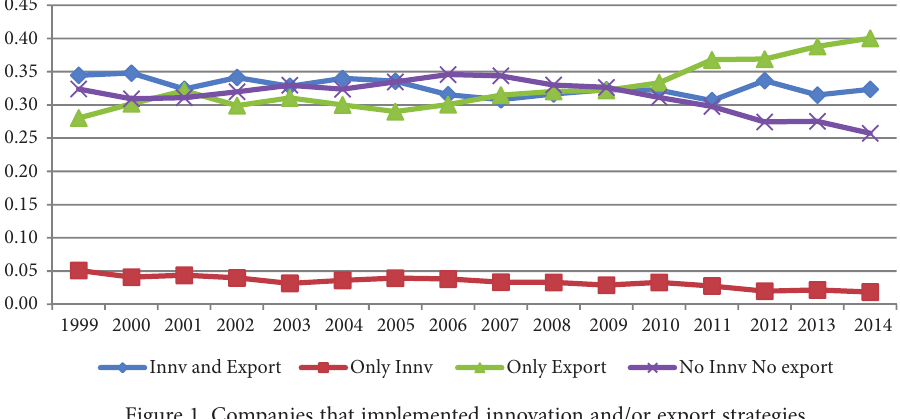
Figure 1. Companies that implemented innovation and/or export strategies in the 2000–2014 period (%)